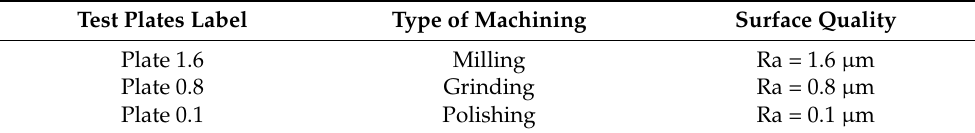
Table 1. Parameters of the surface of the injection